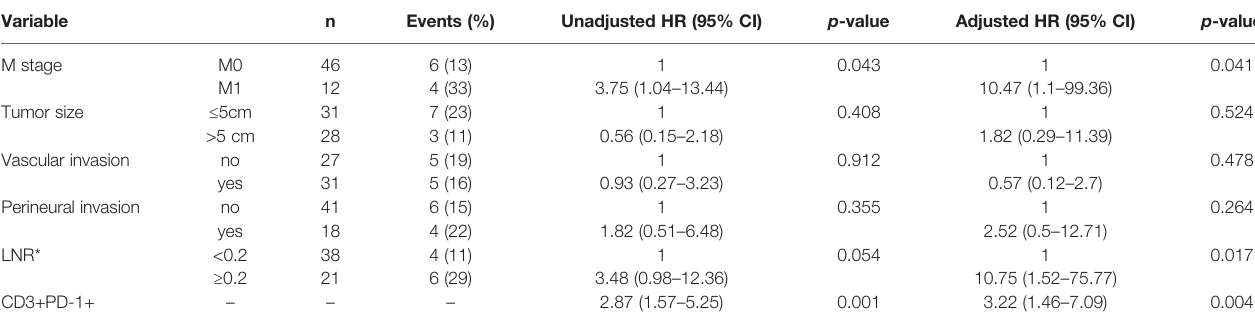
TABLE 3 | Multivariate analysis of overall survival in advanced-stage dMMR CRCs.